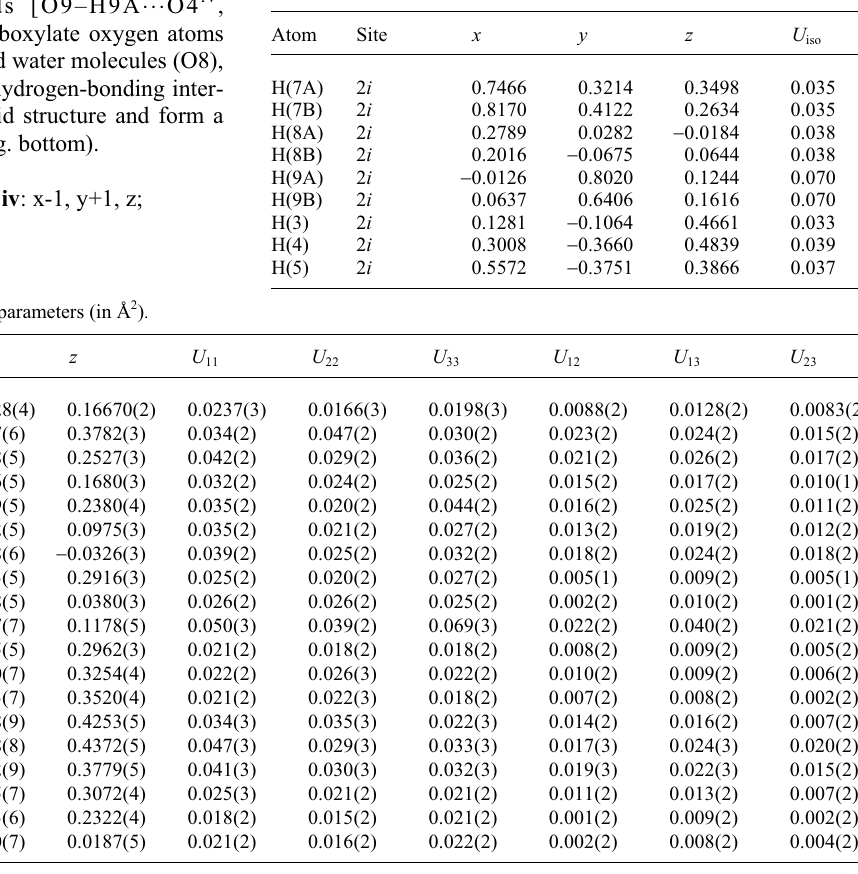
Table 2. Atomic coordinates and displacement parameters (in Å 2 )